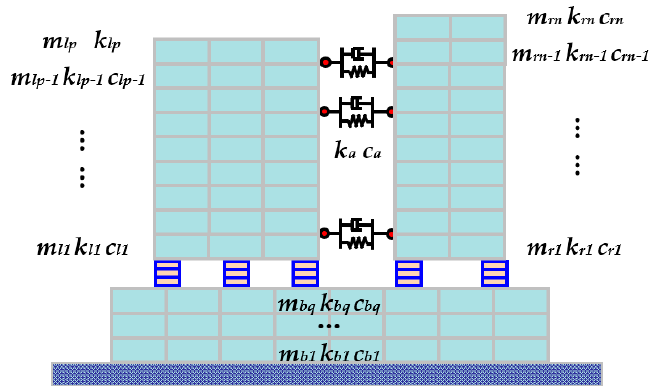
Figure 1. Calculation diagram of multi-DOF (degrees of freedom) layer shear model of multi-tower building (MTB) with the adopted compositive passive control (CPC) method.